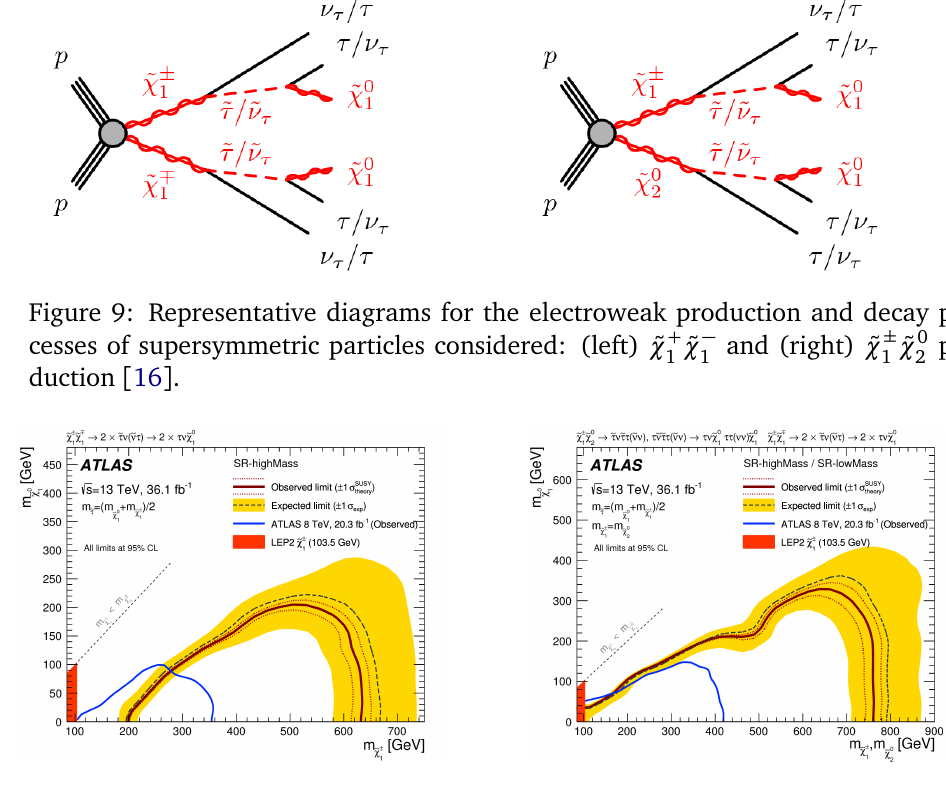
Figure 10: The 95% CL exclusion contours for simplified models with ˜ χ + tion (left) and production of ˜ χ + duction cross sections and short decay chains for ˜ χ ± neutralinos decay into the lightest neutralino via an intermediate on-shell stau or tau sneu- −→ ˜ τν ( ˜ ν τ ) −→ τν trino, ˜ χ ± τ τ 1